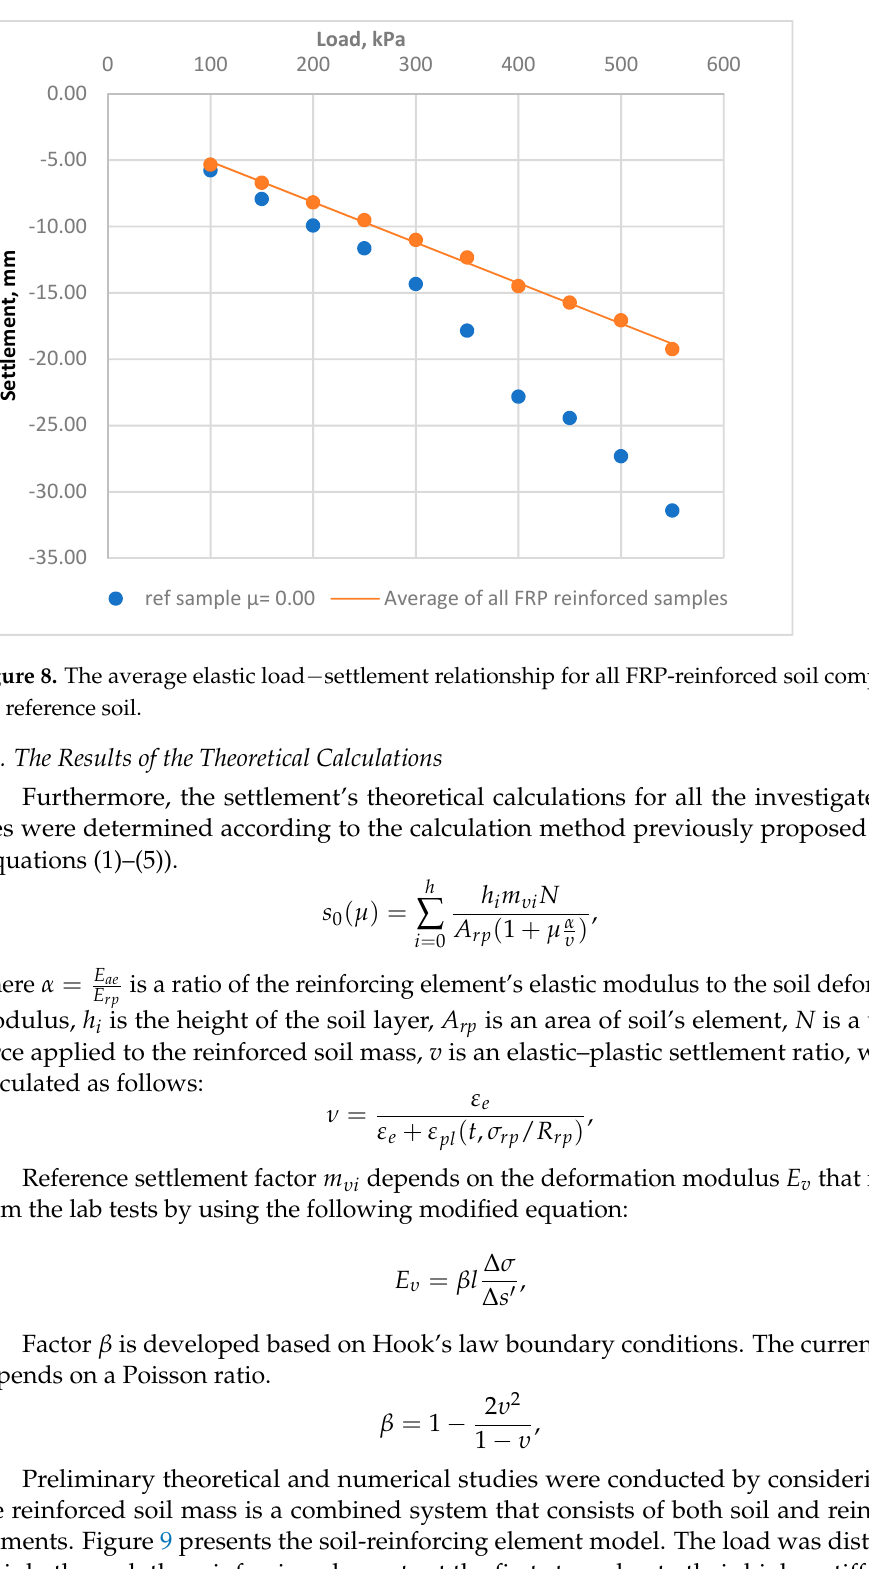
Figure 7. The in situ PLT elastic deformation before and after the reinforcement for varied reinforcement areas.